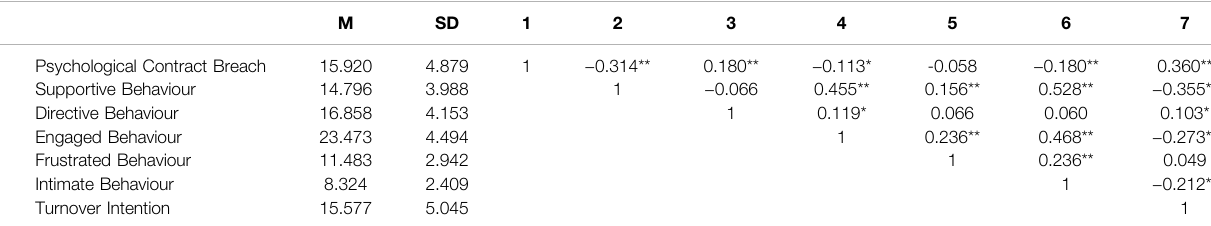
TABLE 1 | Descriptive Statitistics and correlation matrix.